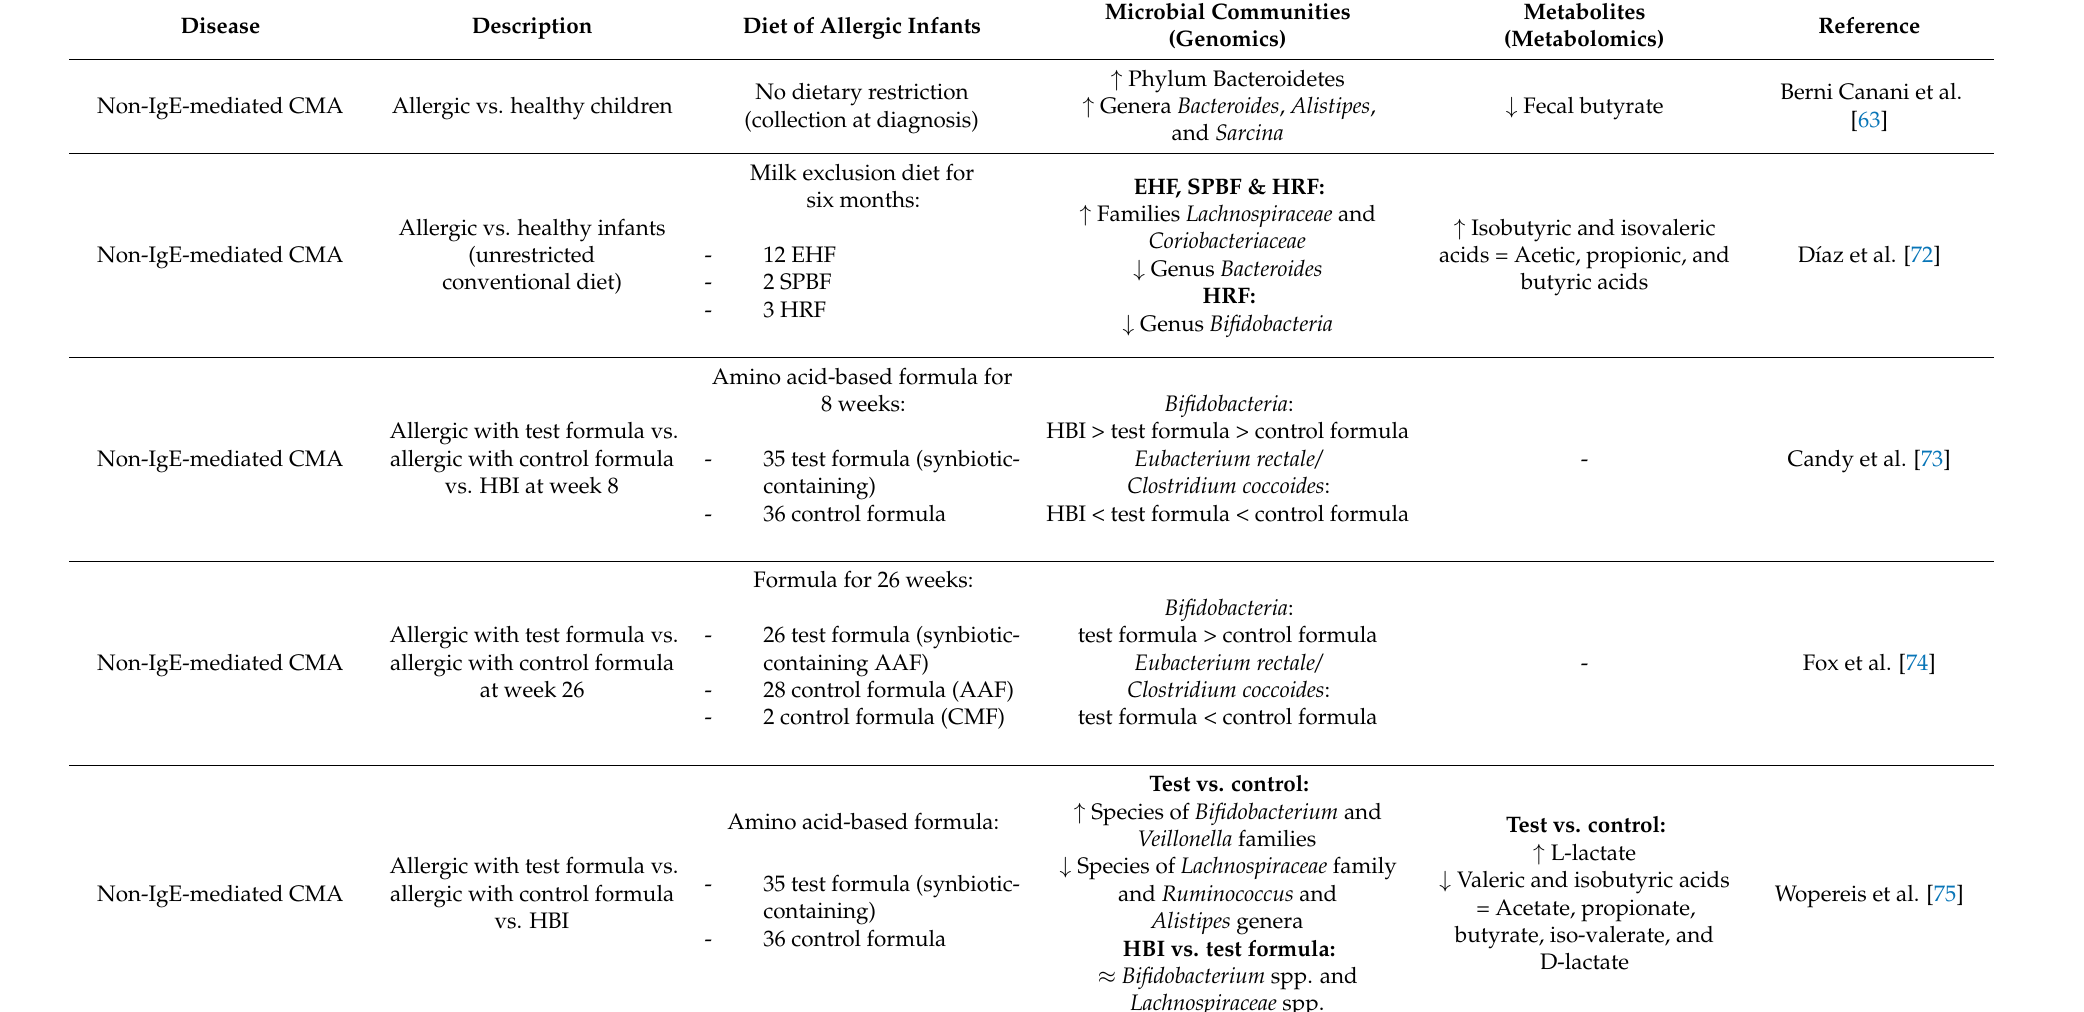
Table 1. Summary of described studies using genomics and metabolomics to study